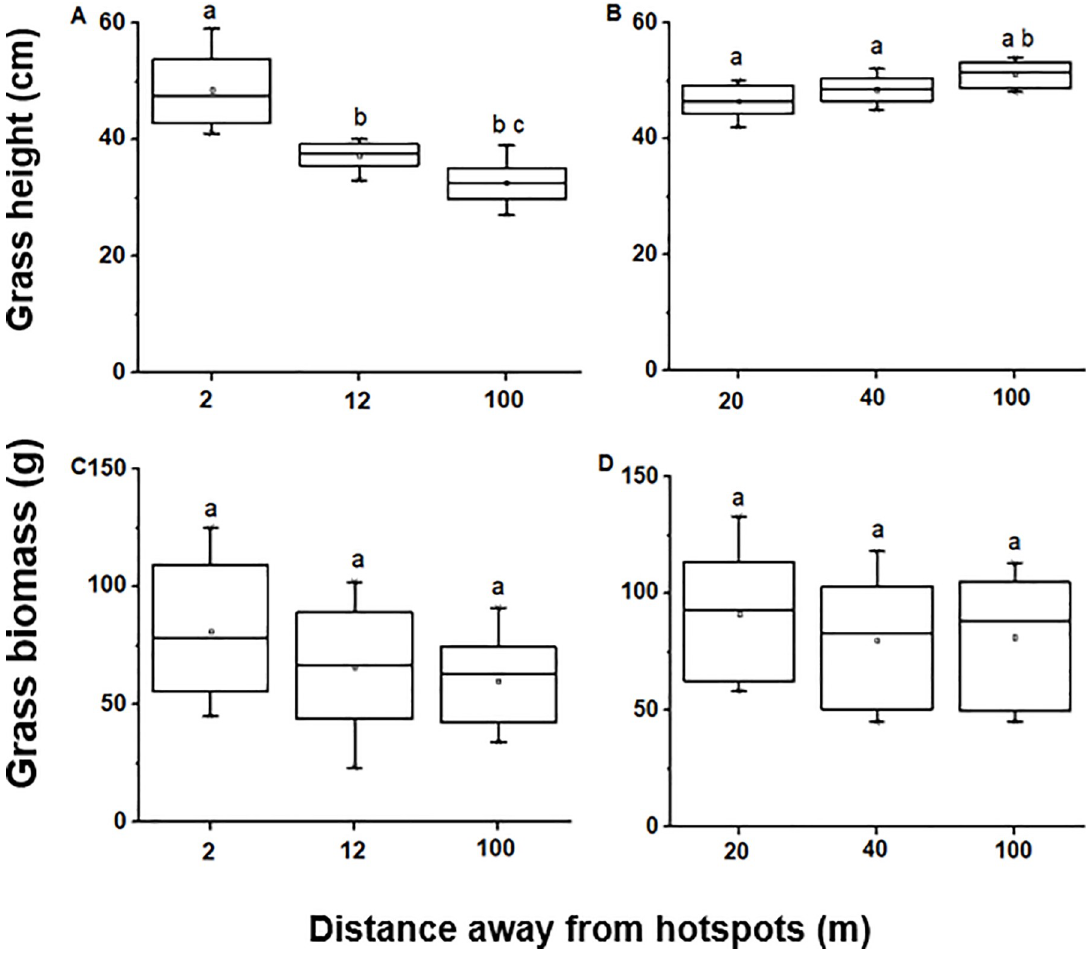
Fig 1. Mean grass height (in cm) and grass biomass (in g) measured as moving away from the influence of termite mounds (A, C) and grazing lawns (B, D), respectively. N = 10 for termite mounds, and N = 6 for grazing lawns. Boxplots show the mean (a square within boxes) and ranges from 25% and 75% quartile (boxes), and the tips of the whiskers indicate standard deviations. Boxes with different letters indicate significantly different means as tested by Fisher LSD at P =